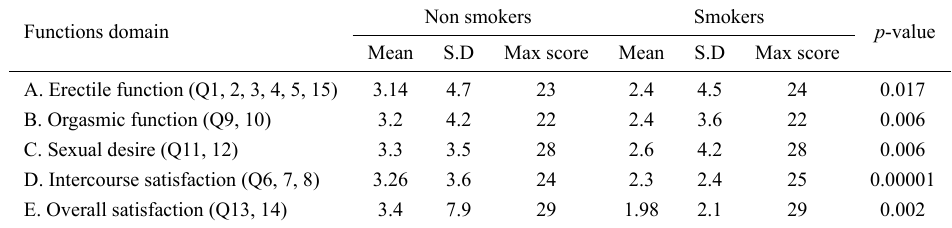
Table 1. Comparison between erectile function domains among smokers and non-smokers.